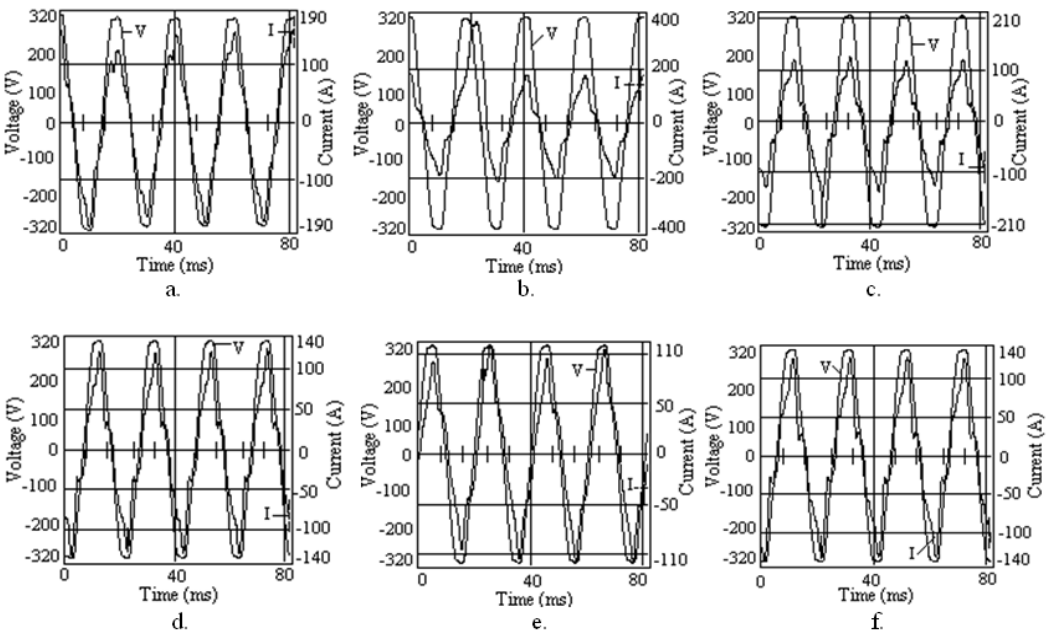
Figure 21. Fast current transients from the electrical power substation.